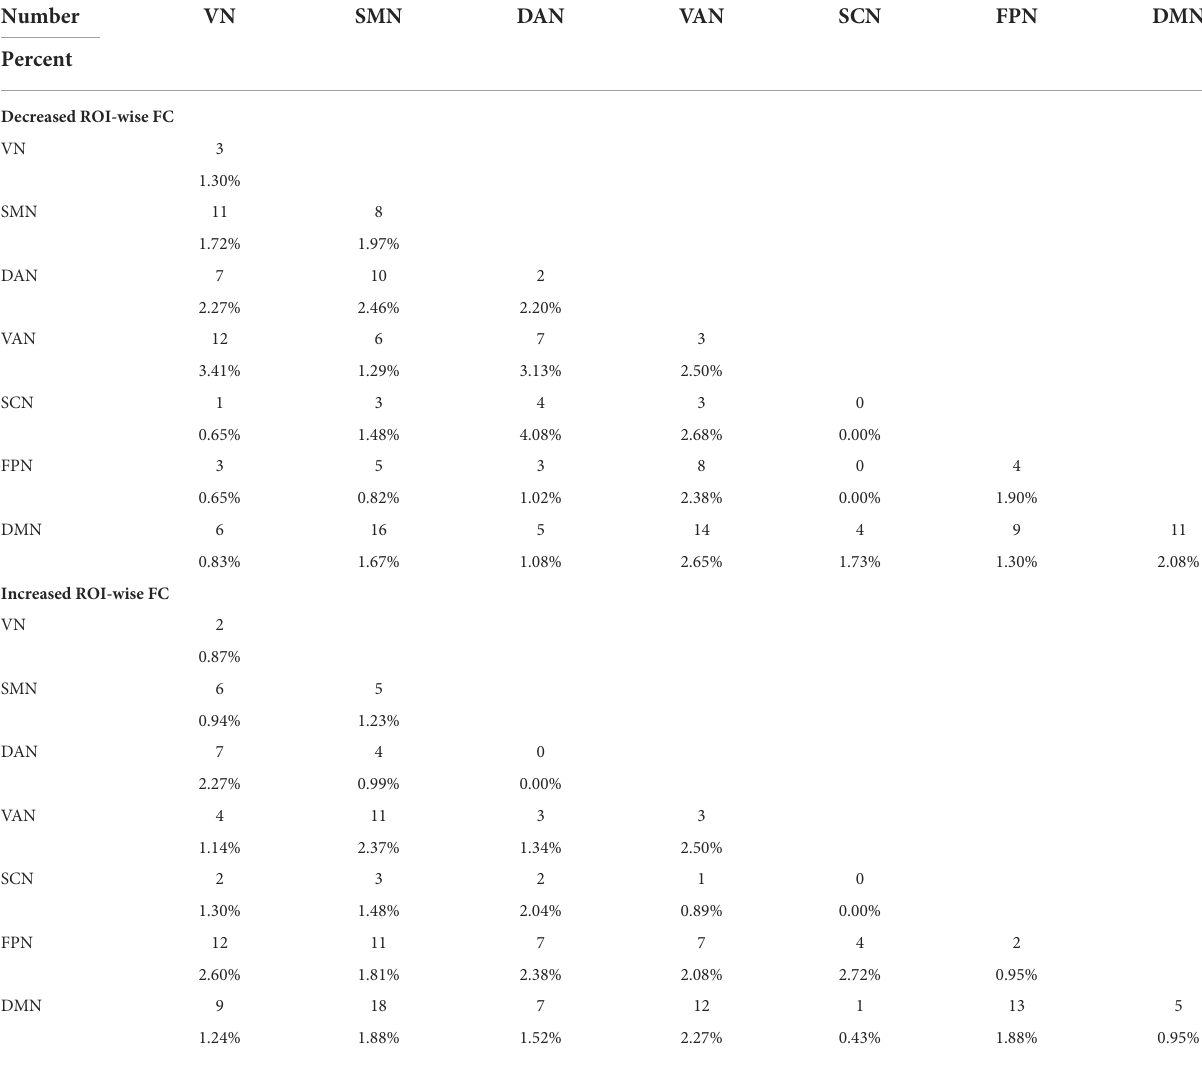
TABLE 2 Number and ratio of decreased and increased ROI-wise FC for acute SD subjects between after and before acupuncture. Number VN SMN DAN VAN SCN FPN DMN